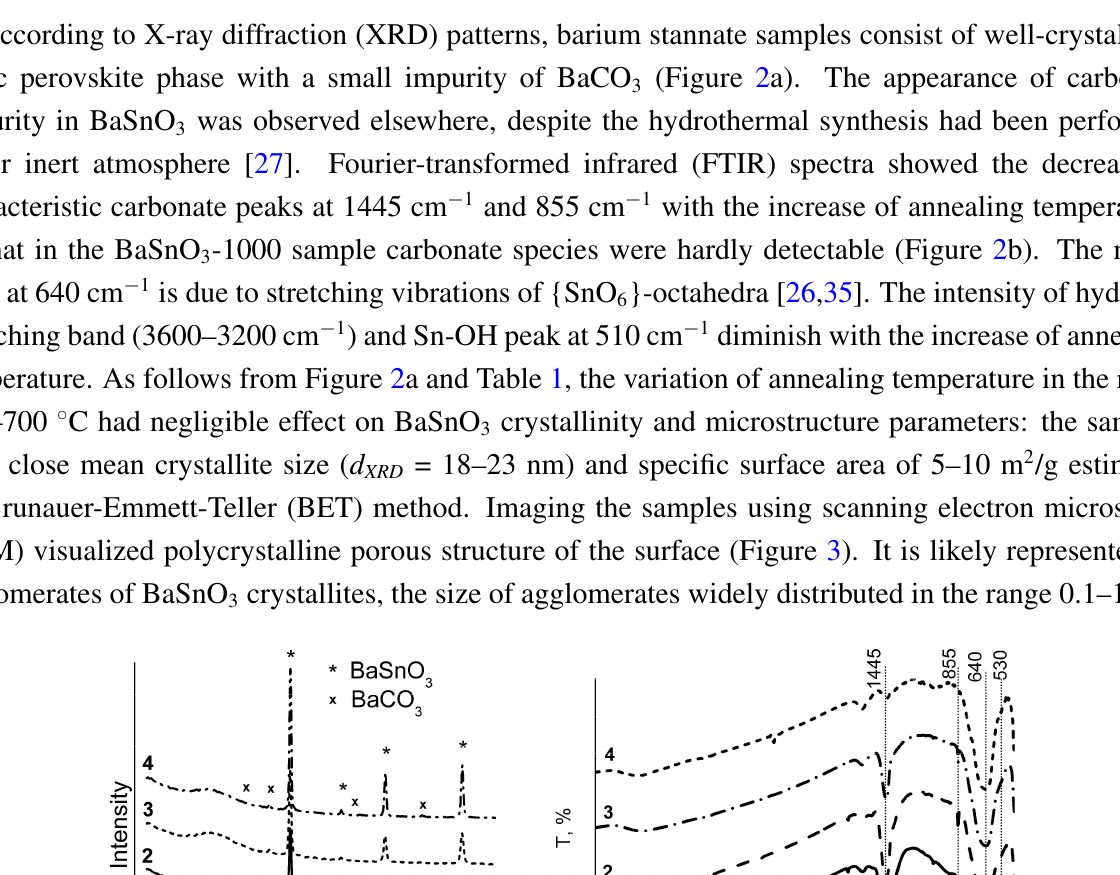
samples annealed at 3